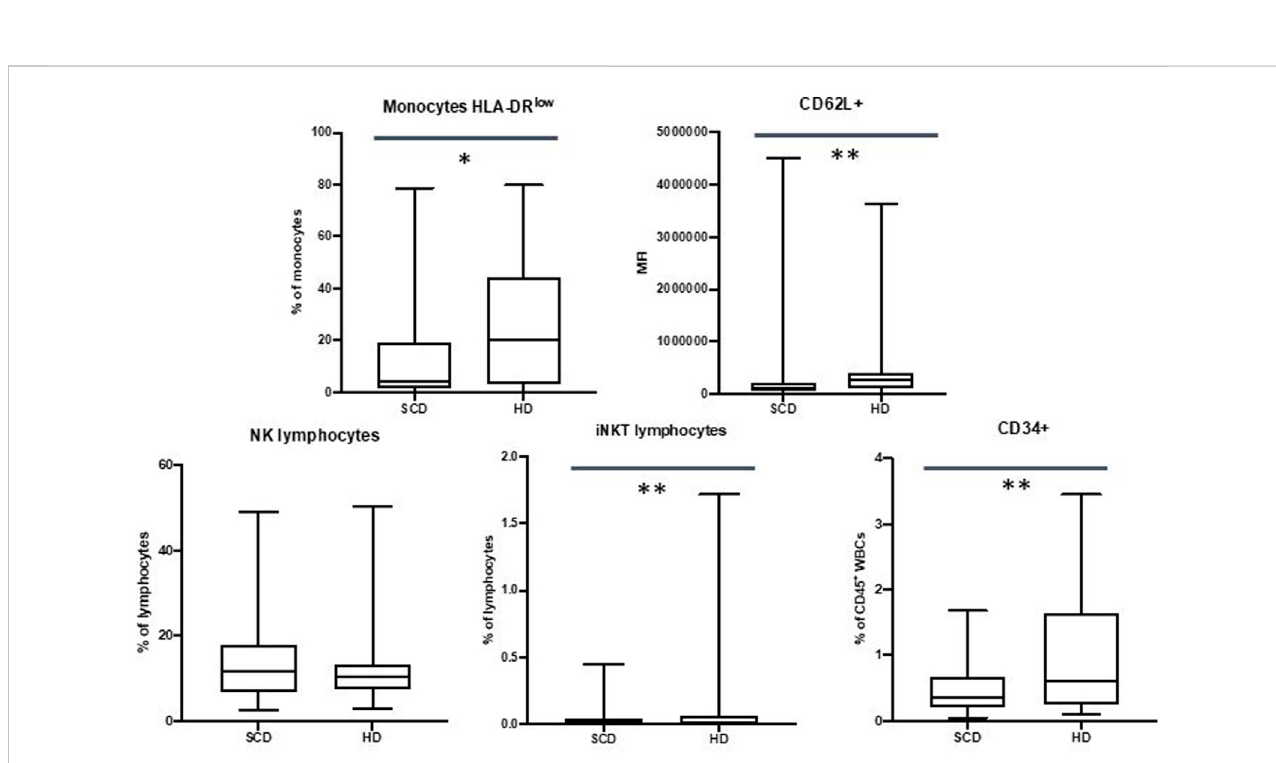
FIGURE 2 Differences in HLA-DR low monocytes, CD62L + neutrophils, NK lymphocytes, iNKT lymphocytes and CD34 + cells between sickle cell disease (SCD) patients and healthy donors (HD). * p ≤ .05; ** p ≤ .01; *** p ≤ .001.